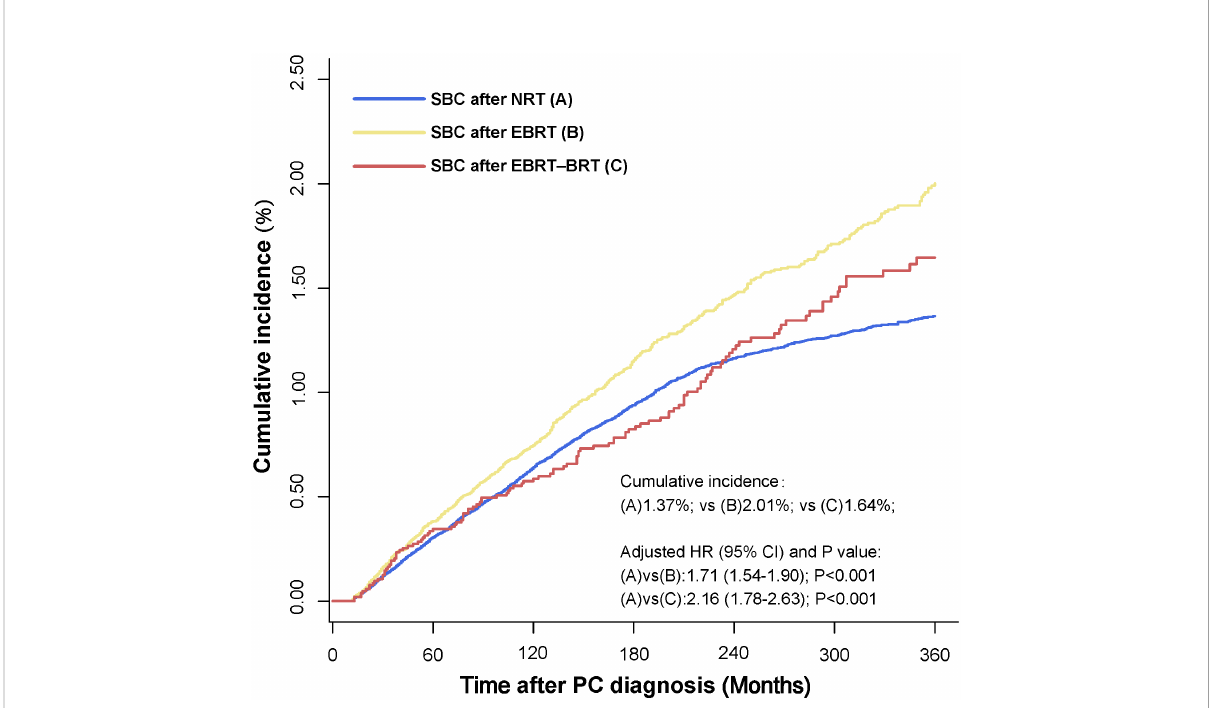
FIGURE 2 Comparisons of cumulative incidence of secondary bladder cancer (SBC) between patients who received radiation therapy (RT) and patients who did not receive RT. P values were calculated with the Fine-Gray test. PC, pelvic cancers; SBC, secondary bladder cancer; HR, hazard ratio; CI, con fi dence interval; NRT, no radiation therapy; EBRT, external beam radiation therapy; EBRT – BRT, external beam radiation therapy with brachytherapy involving implants or isotopes.